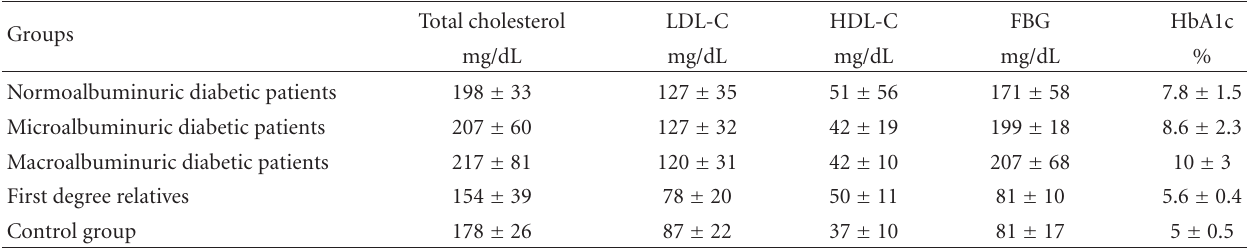
Table 3: Comparison of lipid parameters, fasting plasma glucose, and HbA1c in all groups of the study. Groups